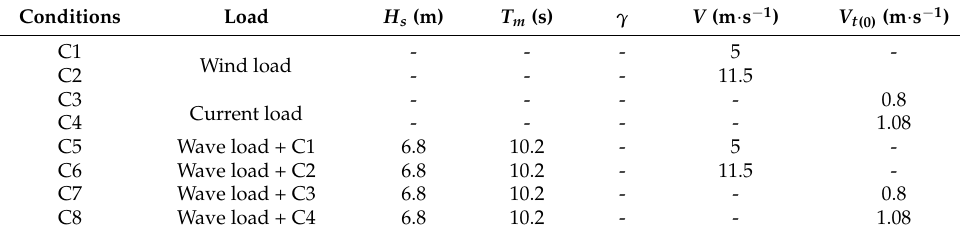
Table 3. Different combinations of survival